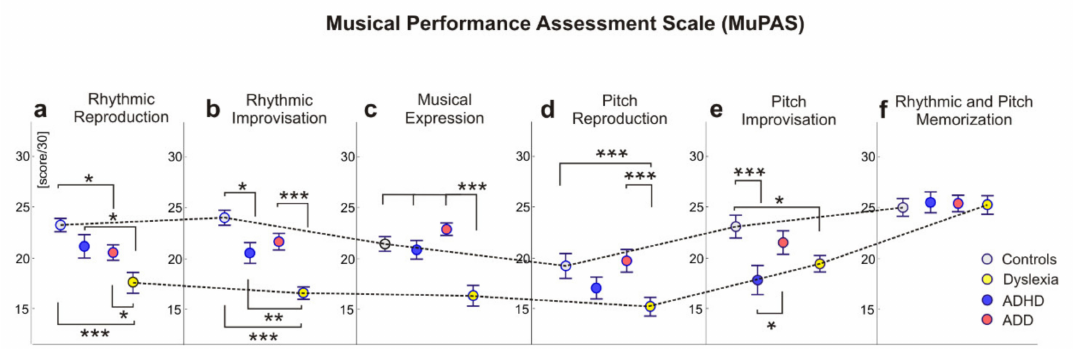
Figure 2. Means and post hoc comparisons of the Musical Performance Assessment Scale by diag- noses. Asterisks indicate the significance (* p < 0.05, ** p < 0.01, *** p <